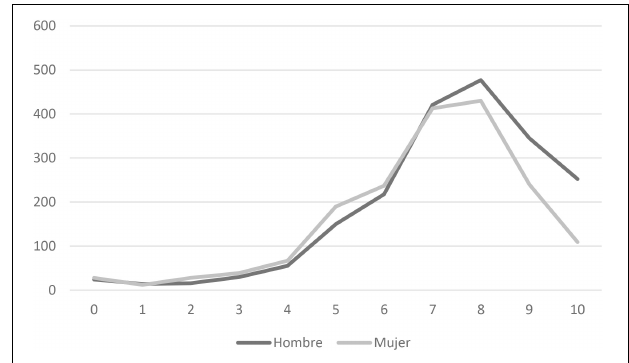
FIGURE 1 | Graphical representation of sex-differences in self-efficacy.